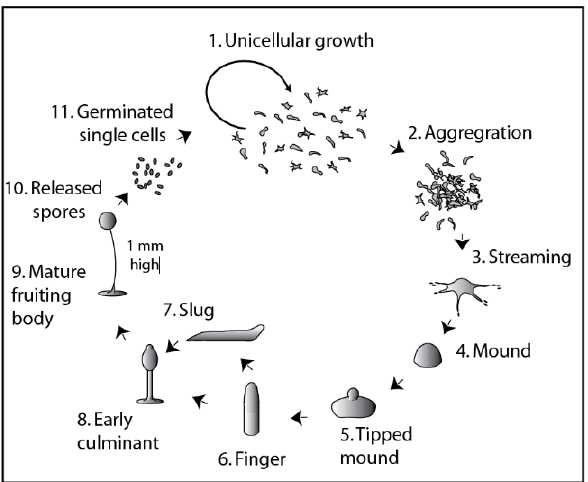
Figure 1. Dictyostelium discoideum has both single-celled and multicellular phases in its life cycle. Dictyostelium cells proliferate in the unicellular phase by mitotic division. Upon starvation, cells aggregate through chemotaxis to cAMP. Development proceeds through streaming, mound and tipped mound formation, leading to the multicellular finger stage. At this stage, development can bifurcate, either forming a migratory slug-like structure or progressing straight to an early culminant and finally a mature fruiting body of around 1 mm in height, containing spores in a spherical spore head. These dormant cells are resistant to dehydration and starvation and, subsequently, are released to renew their cycle of unicellular growth.